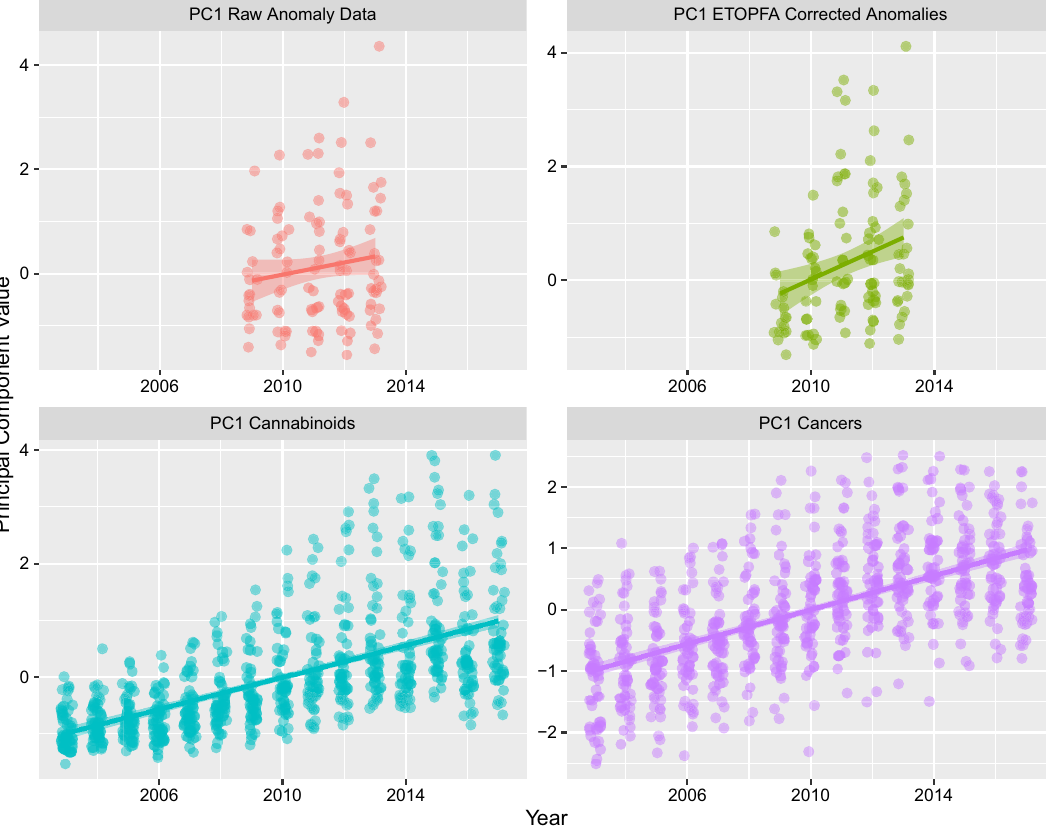
Table 6. These results confirm formally the visual impressions from inspection of Supplementary Figs. 13–15 of important changes at higher quintiles of cannabinoid exposure with high levels of statistical significance (CAR’s: β-est. = 1.76 (1.22, 2.29), P = 3.81 × 10 –9 ; ETOPFACAR’s: β-est. = 1.59 (1.04, 2.14), P = 1.15 × 10 –7 ; cancers: β-est. = 0.43 (0.26, 0.61), P = 1.69 × 10 –6 ).